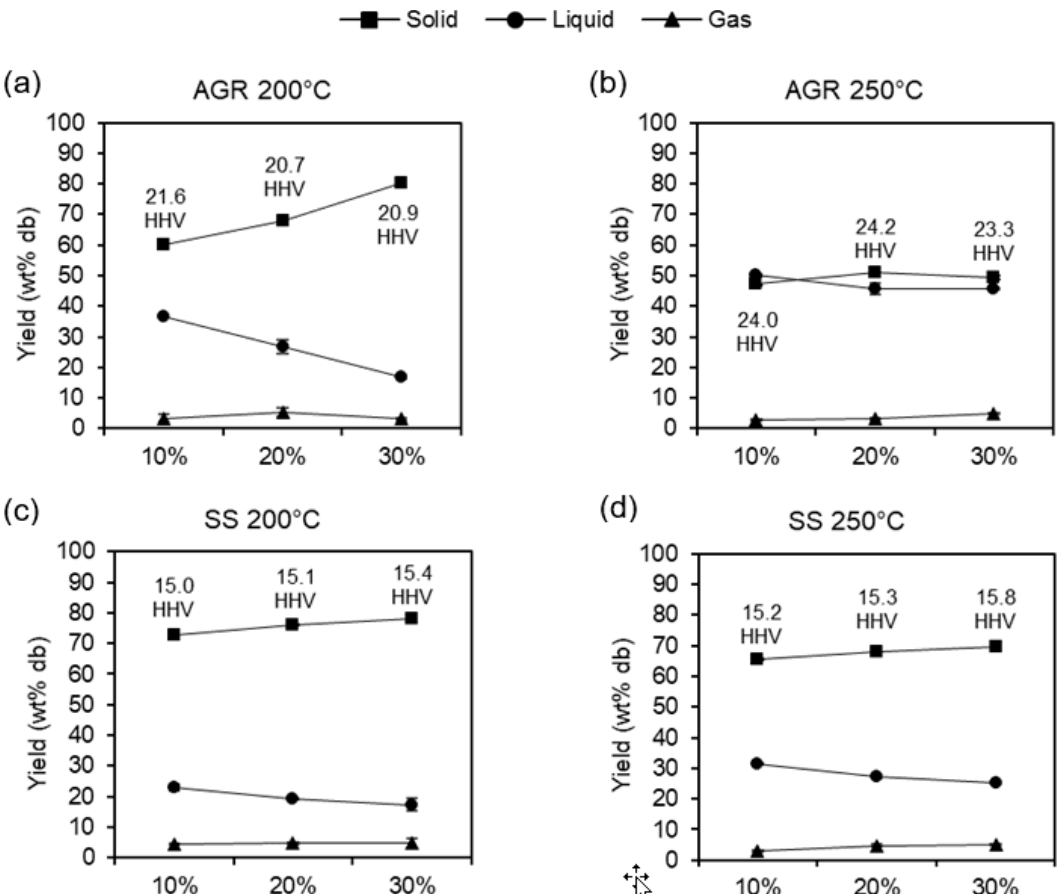
Figure 2. Influence of loading on product yields, including energy content of hydrochar for ( a ) AGR at 200 °C, ( b ) AGR at 250 °C, ( c ) SS at 200 °C, ( d ) SS at 250 °C on a dry basis (db), based on duplicate data and error bars represent deviation around the mean.